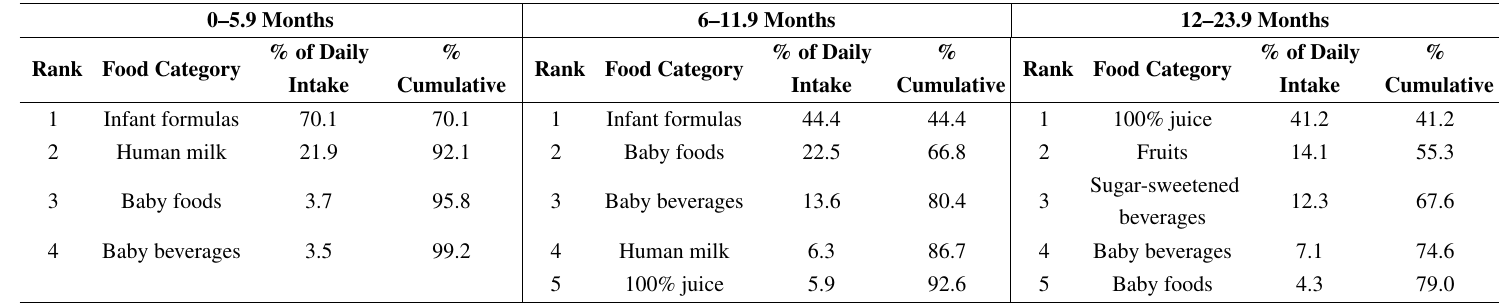
Table 11. Food sources of Vitamin C among US infants and toddlers aged 0–23.9 months by age group: NHANES 2005–2012 ( n = 2740) a